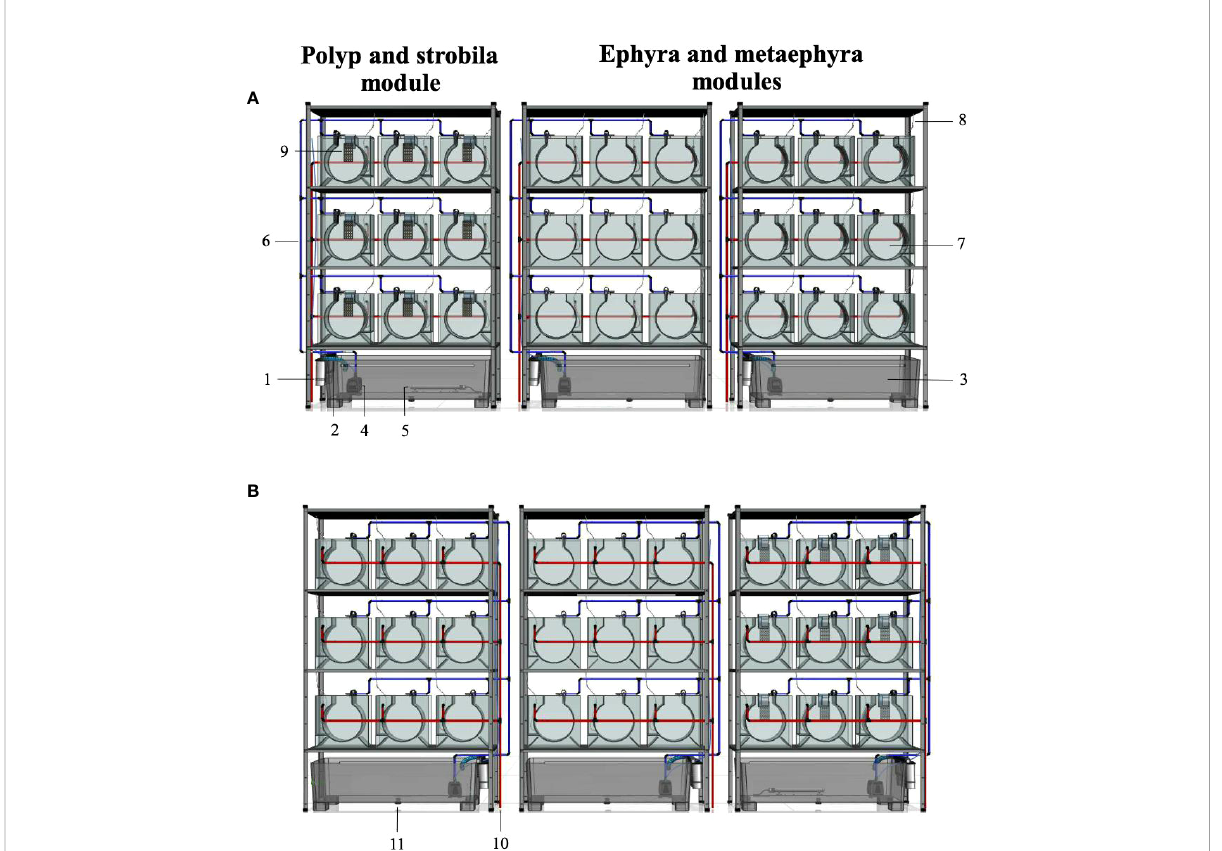
FIGURE 4 Schematic representation of a fl ow-through system of jelly fi sh biomass production for metagenetic and holoplanktonic species. (A) Frontal view. (B) Posterior view. System con fi guration: 1, fi lter system composed of fi lter cartridges; 2, water inlet towards the sump; 3, sump; 4, water pump; 5, heater; 6, individual water inlet to each kreisel (blue pipe); 7, kreisel; 8, individual air inlet to each kreisel; 9, polyp plate; 10, water drainage (red pipe); 11, screw cap for emptying the sump. Notes: Polyp plates with strobilae can be easily moved to the ephyra and metaephyra modules during the strobilation process; Fertilized eggs of Pelagia noctiluca can be metamorphosed into the ephyra and metaephyra